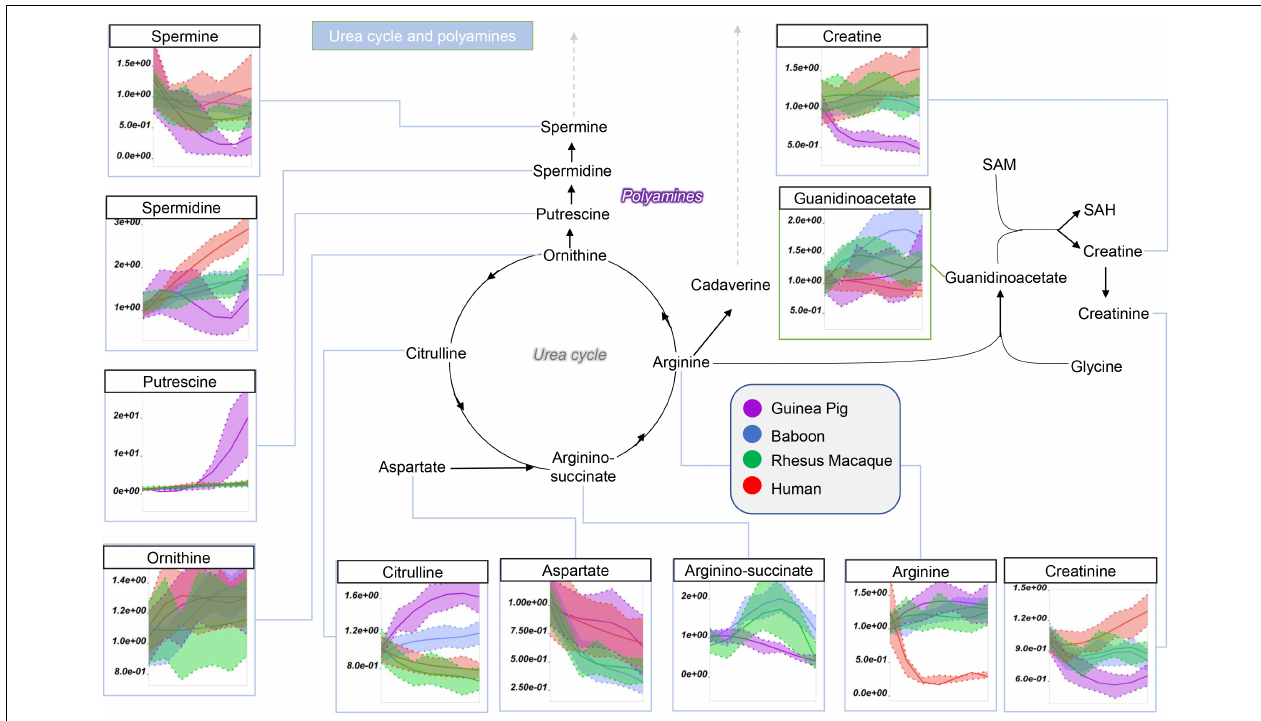
FIGURE 6 | Impact of storage on arginine and polyamine metabolites in RBCs from guinea pigs (violet), baboons (blue), rhesus macaques (green), and humans (red). Line plots indicate metabolite medians (lighter colored areas are ranges) normalized to measurements in fresh, non-stored blood (day 0) and autoscale normalized across groups. All metabolites are significant by ANOVA (FDR corrected– p < 0.05).